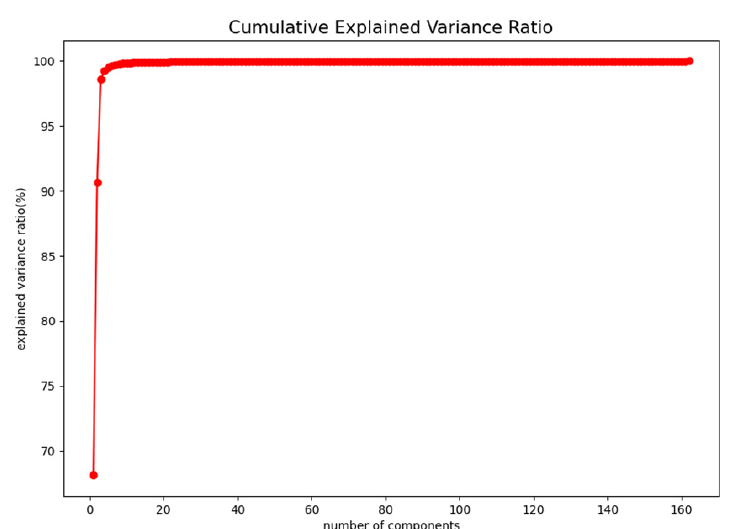
Figure 5. PCA cumulative explained variance ratio.